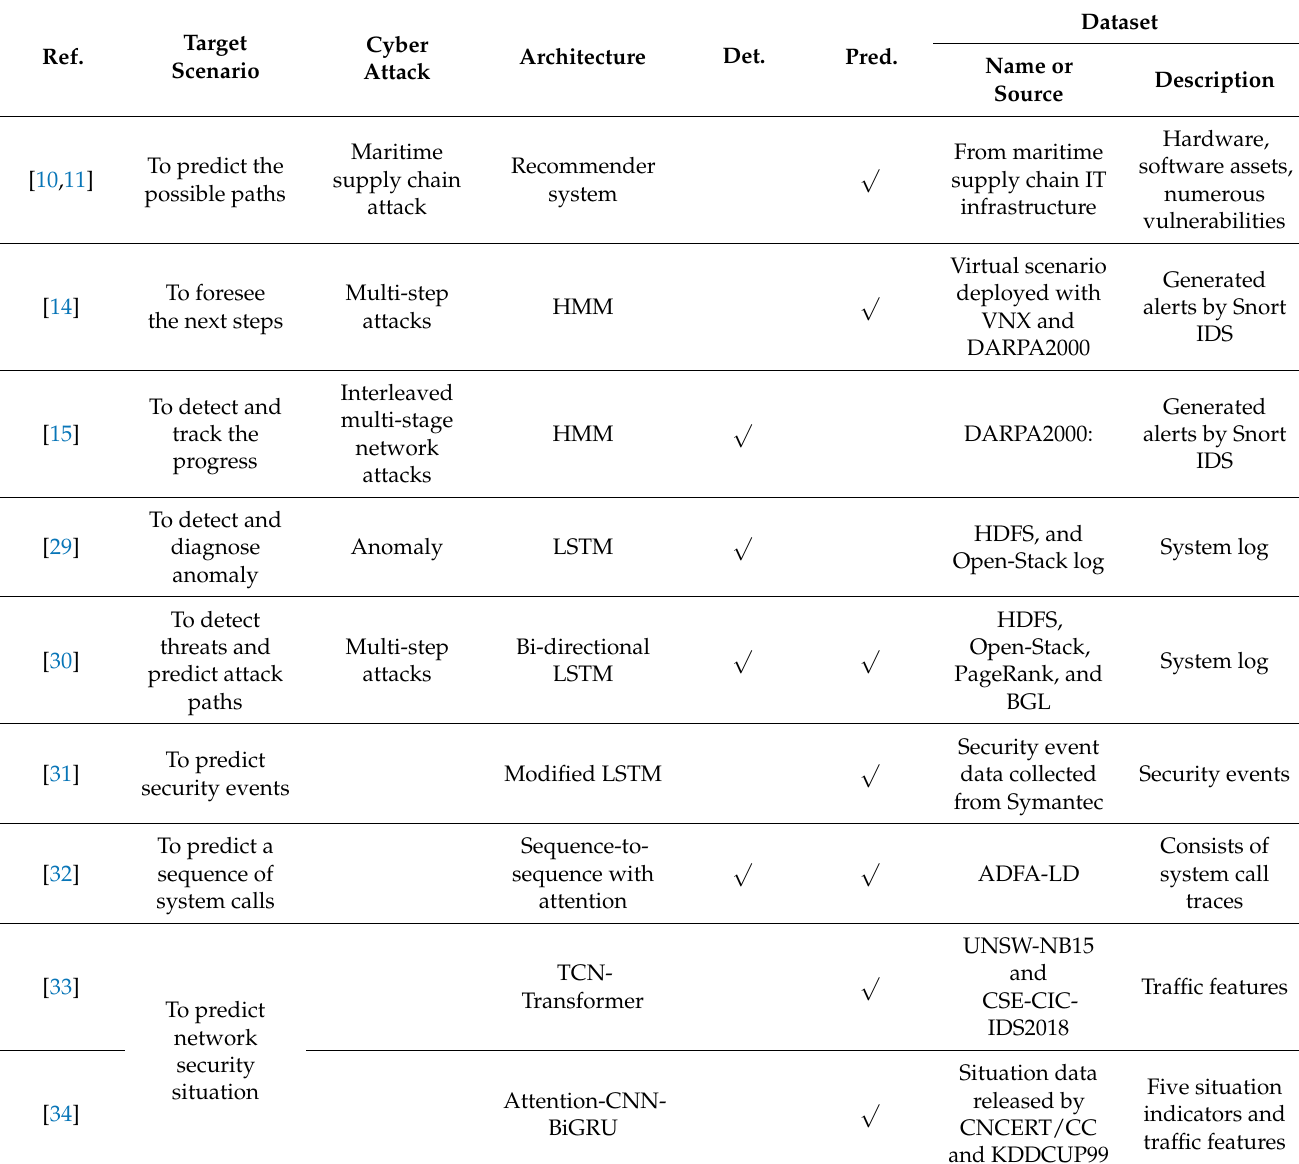
Table 9. Comparison of approaches for predictive